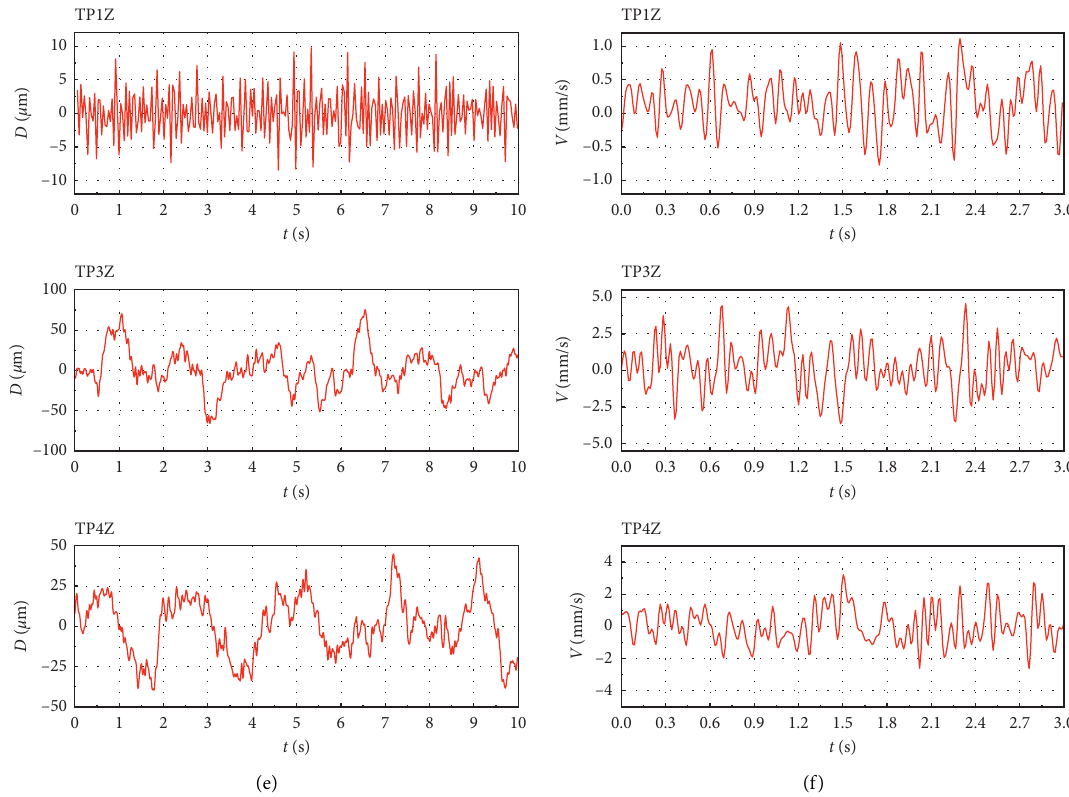
Figure 6: Time-domain waveform: (a) Vertical vibration displacements and (b) vertical vibration velocities of the crusher in the Linyou power plant. (c) Vertical vibration displacements and (d) vertical vibration velocities of the crusher in the Shangluo power plant. (e) Vertical vibration displacements and (f) vertical vibration velocities of the crusher in the Ezhou power plant.